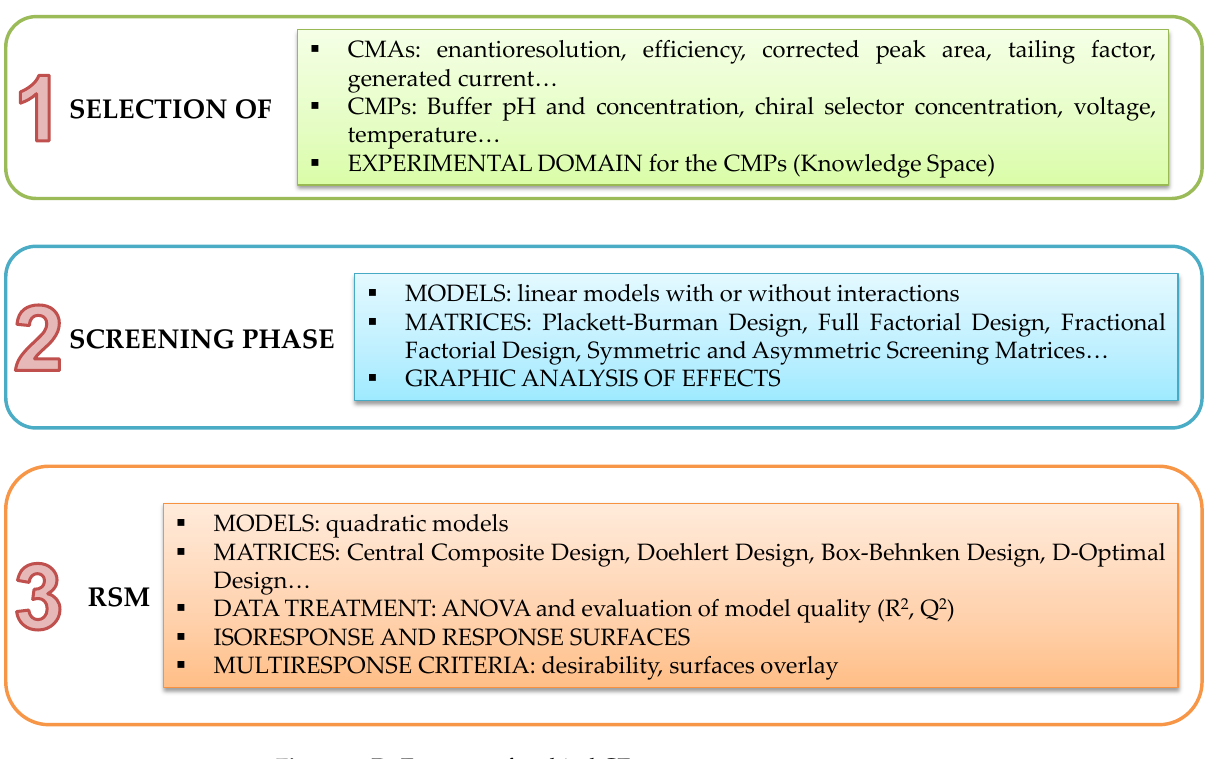
Figure 6. DoE strategy for chiral CE.